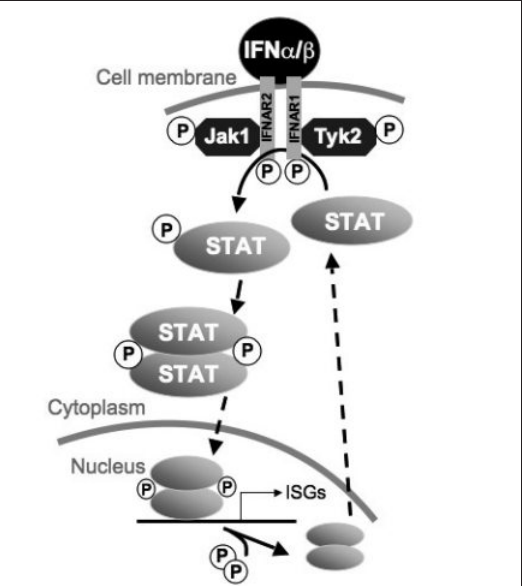
IFN α / β -induced Jak-STAT signalling. Binding of type I IFNs to the IFN α receptor (IFNAR), consisting of the two chains IFNAR1 and IFNAR2, activates the receptor-associated cytoplasmic Janus kinases Jak1 and Tyk2.This leads to phosphorylation and dimerisation of signal transducer and activation of transcription (STAT) proteins that transmit the signal into the nucleus and regulate gene transcription of IFN-stimulated genes (ISGs) by binding to response elements in the host’s